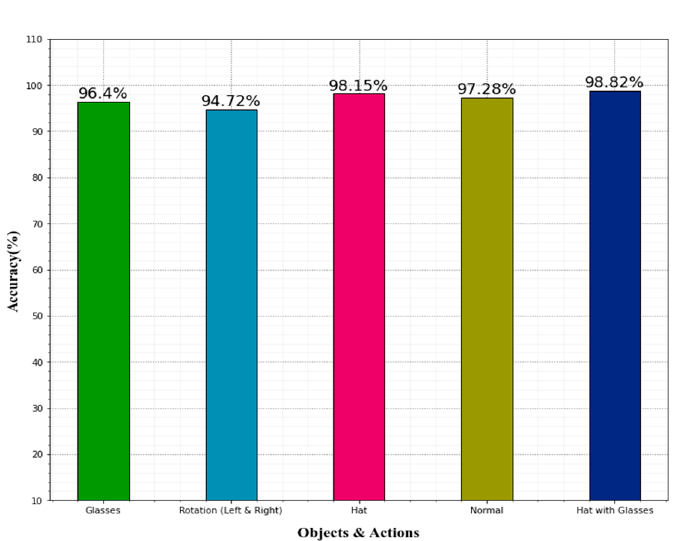
Figure 10. Evaluation of the classifier’s performance in analyzing emotions in terms of accuracy. A confusion matrix is used to describe how well a classification method performs. The output of a classification method is shown and presented in a confusion matrix. The objects and actions including hats, glasses, normal, rotation (left and right), and hats with glasses are the ones that achieved less accurate precision scores in the model, which are shown in Figure 11.